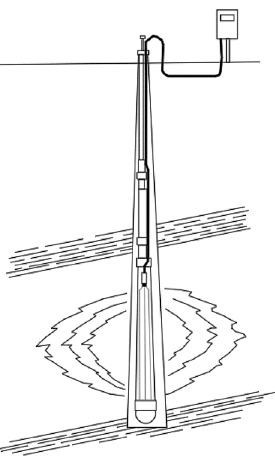
Fig. 3 Example of an electric bottom-hole heater